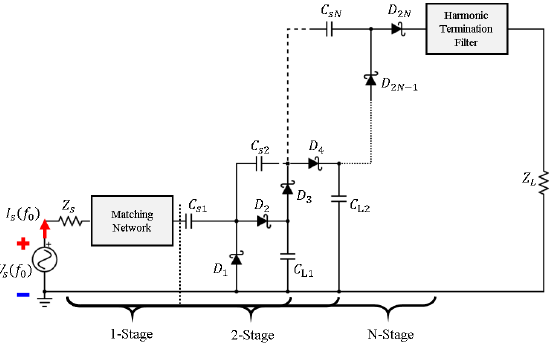
Figure 1. The proposed N-stage HTVM